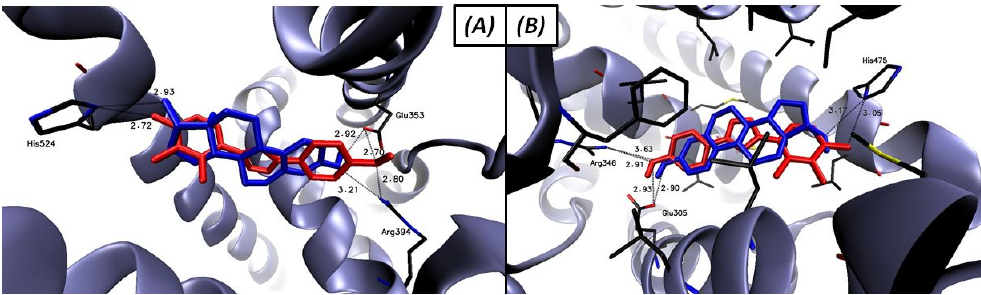
Figure 8. The binding modes of compound 6c (red) and E2 (blue) in the ER α ( A ) and ER β ( B ) binding sites.